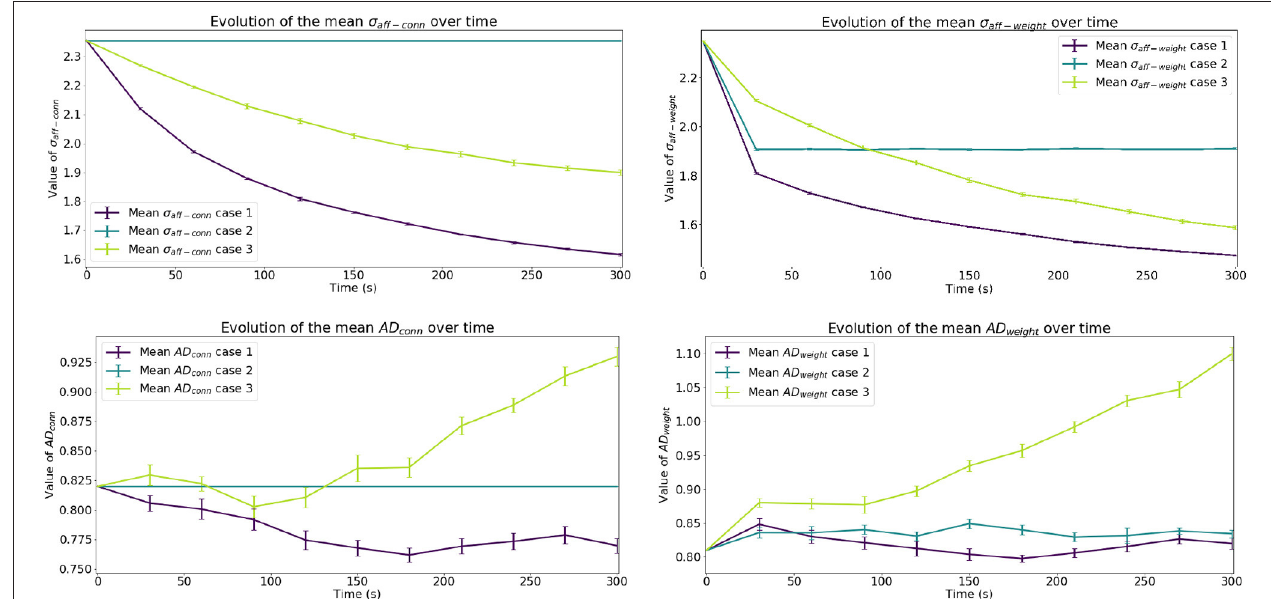
FIGURE 3 | Evolution of results of interest. The top row shows the evolution of the mean spread of receptive fields over time, considering both unitary weights ( σ aff − conn ) and actual weights ( σ aff − weight ) at that point in time. The bottom row shows the evolution of the mean Absolute Deviation of the receptive fields considering connectivity ( AD conn ) and weighted connectivity ( AD weight ). Error bars represent the standard error of the mean.